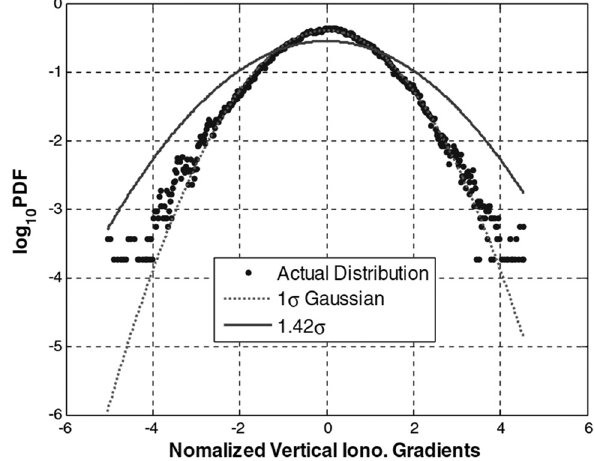
Figure 3: The probability density function of normalized vertical ionospheric gradients on July 2, 2000 ( Lee et al., 2007 )